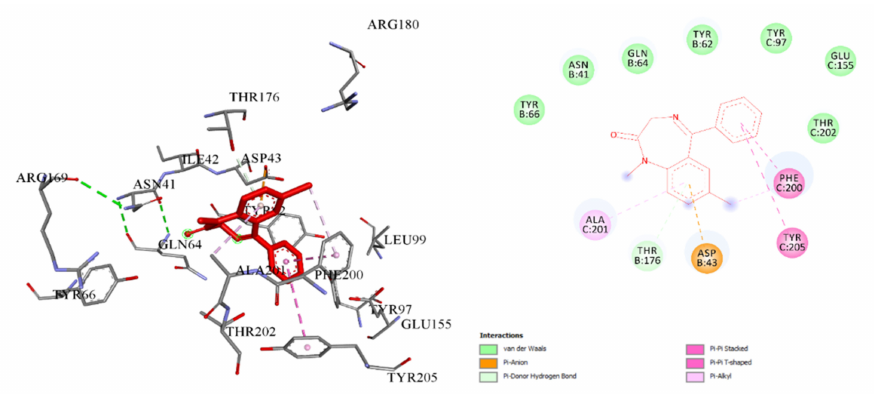
Figure 2. Visualization of the interaction of diazepam with GABA A spatial orientation and confor- mational map of